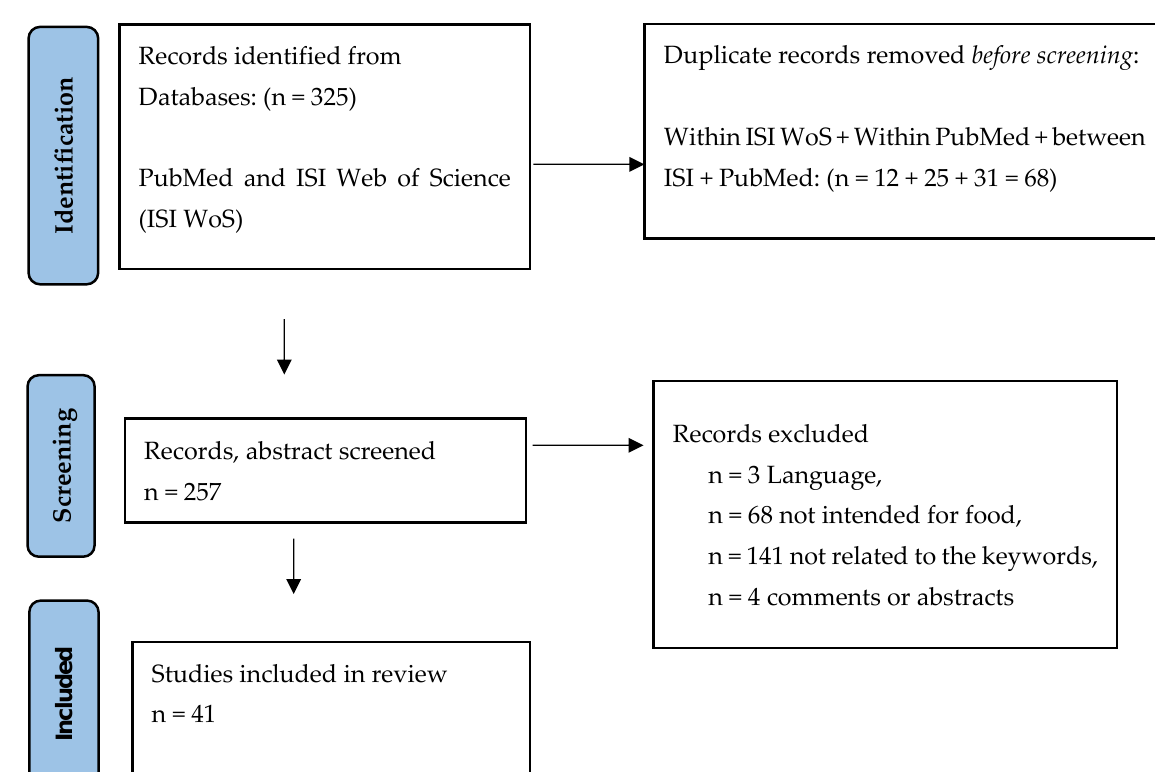
Figure 1. Flow chart of the identification of studies via databases (ISI Web of Science and PubMed), the selection of studies of food safety risks posed by heavy metals and persistent organic pollutants (POPs), by consumption of sea cucumbers. Adjusted PRISMA for the current study, more information https://www.bmj.com/content/372/bmj.n71 (accessed 14th November 2022).